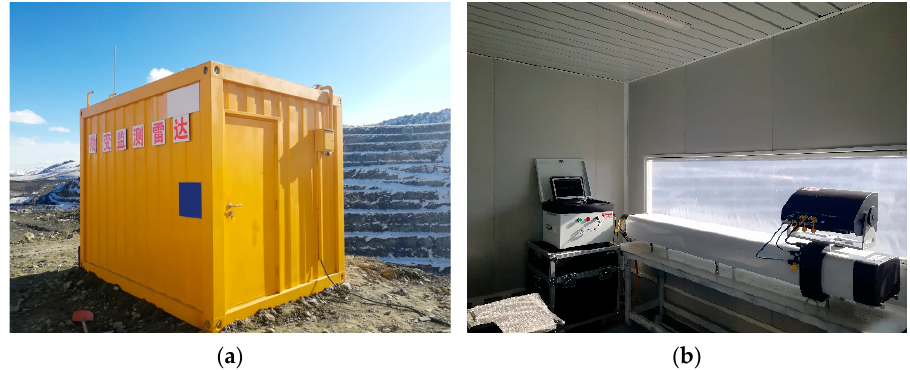
Figure 1. Open-pit mine slope from the radar perspective.